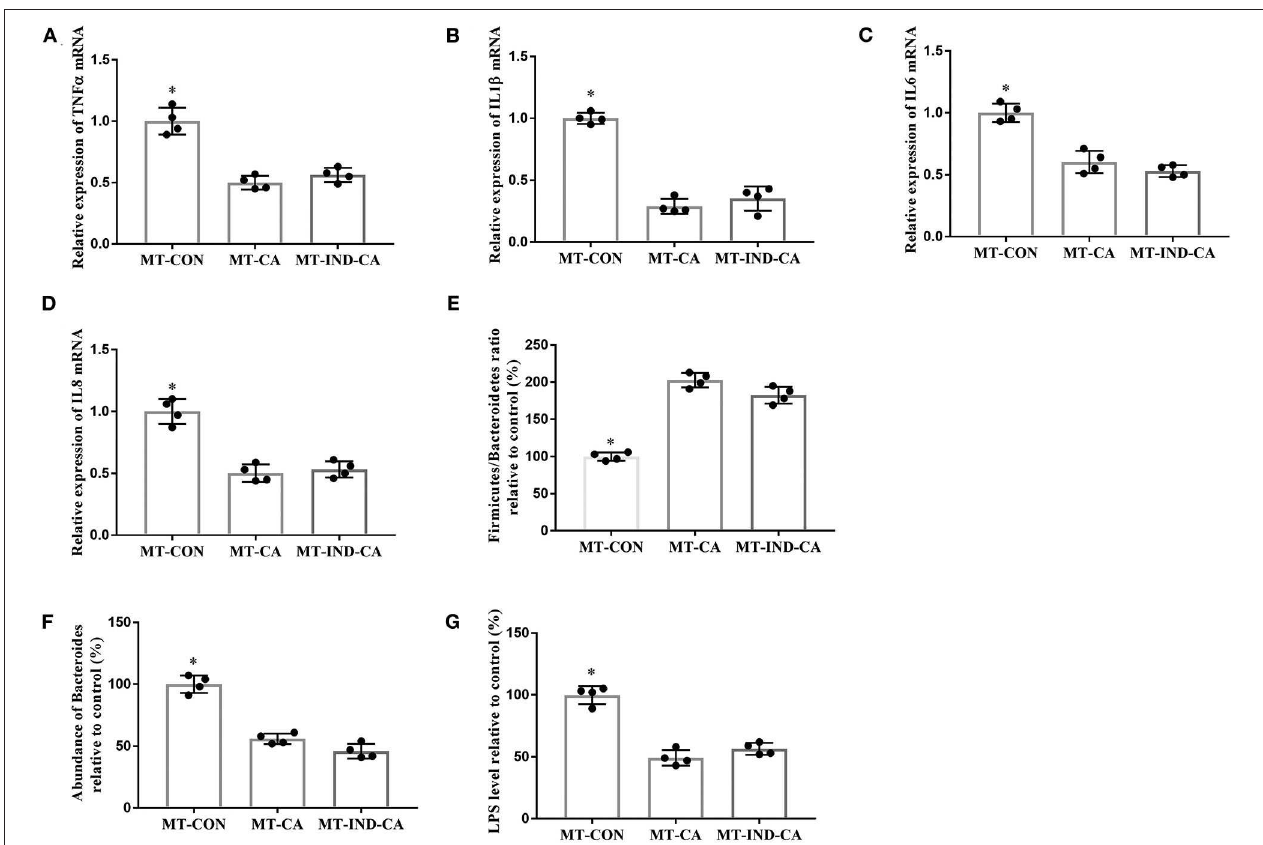
FIGURE 7 | CGA-originated microbiota prevented intestinal inflammation and inhibited the growth of LPS-producing Bacteroides caused by indomethacin. Relative mRNA expression of TNF α (A) , IL1 β (B) , IL6 (C) , and IL8 (D) ; (E) Relative ratio of Firmicutes to Bacteroidetes ; (F) Relative abundance of Bacteroides at the genus level; (G) Relative LPS content in the colonic tissue. Values are expressed as mean ± SEM, n = 4. * P <